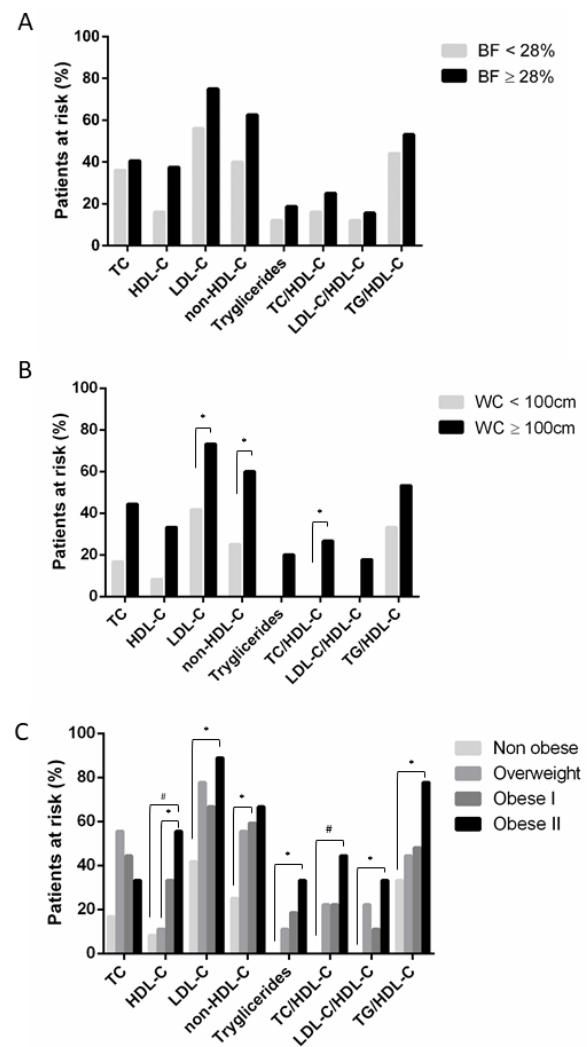
Figure 2. Cardiovascular risk evaluation attending to body fat percentage (BF, panel ( A )), attending to waist circumference (WC, panels ( B , C )). Each bar shows the percentage of patients at risk for cardiovascular events depending of lipid profile. HDL-C: high-density lipoprotein cholesterol; LDL-C: low-density lipoproteins cholesterol; TC: total cholesterol; TG: triglycerides; Significance is indicated when p < 0.05 (*) or p < 0.01 (#). Table 9. Correlation study between body fat percentage (BFP) and waist circumference (WC) vs. lipid profile. BFP Correlation WC Correlation TG (mg / dl) NS